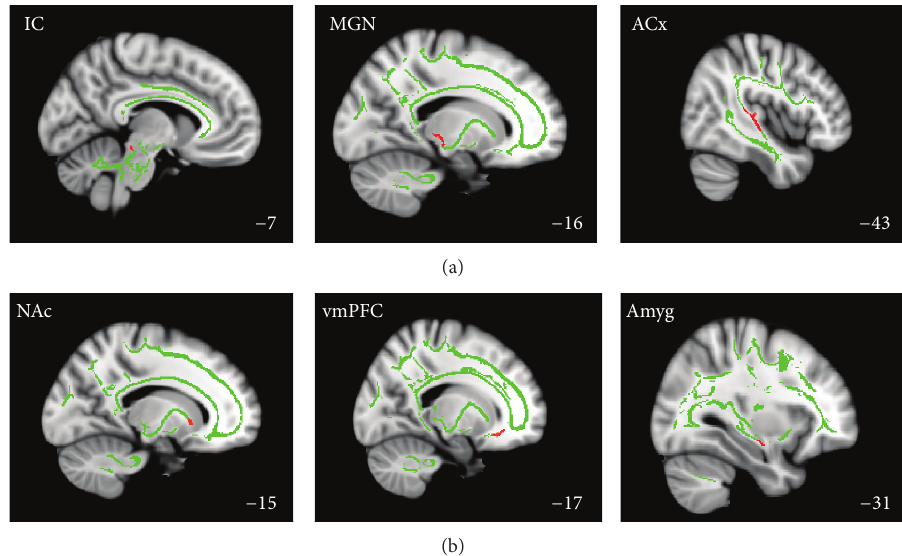
Figure 1: Regions of interest. Auditory (a) and limbic (b) ROIs (red) overlayed on the WM skeleton (green) superimposed on the MNI152 brain template. Numbers in the bottom right corner indicate the MNI 𝑥 -coordinate of the illustrated sagittal